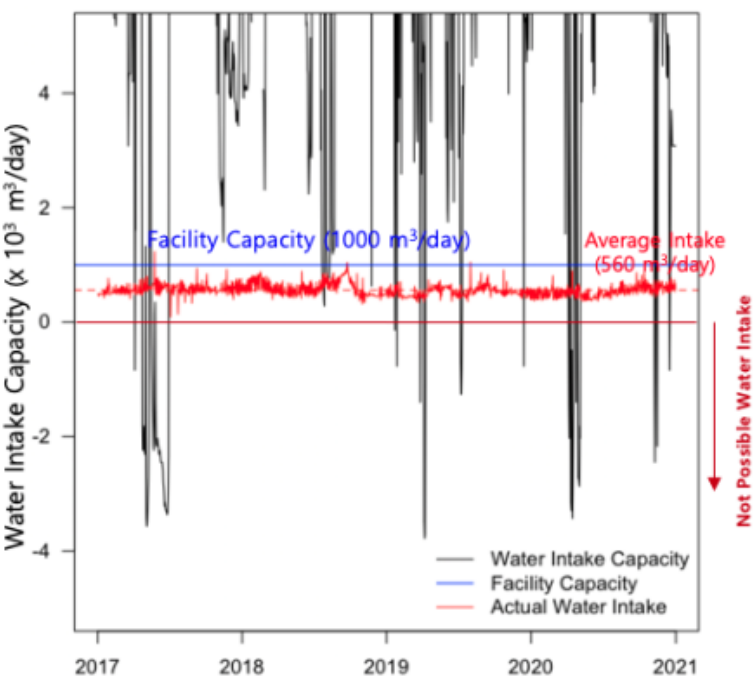
Figure 5. Comparison results between the estimated water intake capacity (WIC) and actual water intake at the Chungsan water intake plant (CWIP) from 2017 to 2020.